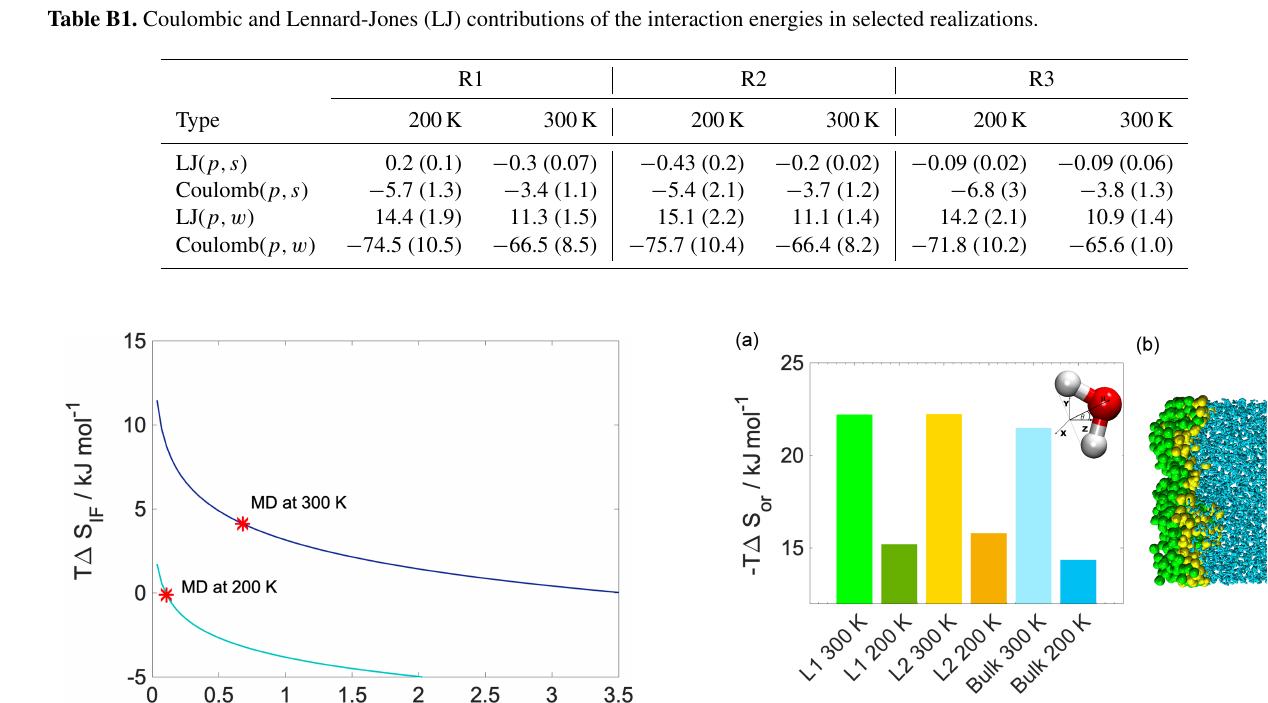
Figure B4. (a) Orientational entropies in the first and second molec- ular layers and the bulk phase for both simulated temperatures. In- set: the definition of the θ angle. (b) Snapshot from a 300K realiza- tion showing the first two molecular layers of the aqueous phase in green (L1) and yellow